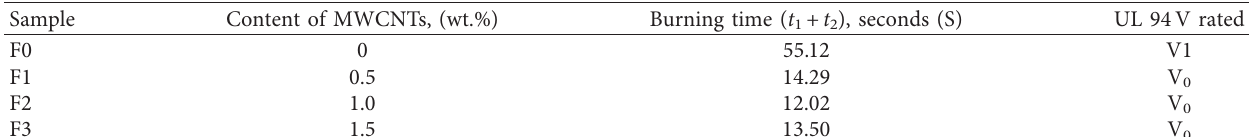
Figure 5: Flame retardant test samples according to UL 94 HB. (a) F1 (0.5 wt.% MWCNTs, 10 wt.% FA). (b) F3(1.5 wt.% MWCNTs, 10 wt.% Table 4: Total burning time ( t 1 + t 2 ) of the nanocomposite